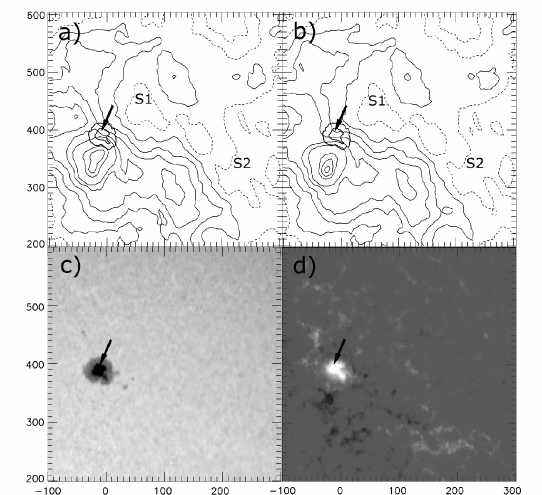
Fig. 2. 1999 May 12 observations of the large sunspot in the AR 8535: (a) the brightness temperature T B x and (b) T B o contour maps of 17 GHz images (NoRH). Here and in the panels 3a and 3b the levels of T B x and T B o are at 0.9, 1.0 (dashed line) and 1.1, 1.2, 1.3, 1.4, 1.5, 2.0, 2.25, 2.5 (solid line) in units of 10 4 K. The arrow points to the location of the reduced emission in o-mode. (c) The white light image (NSO/KP) and (d) the longitudinal magnetogram (SOHO MDI). The axis units are in seconds of arc from the center of the solar disk; solar north is up, solar west is to the right.